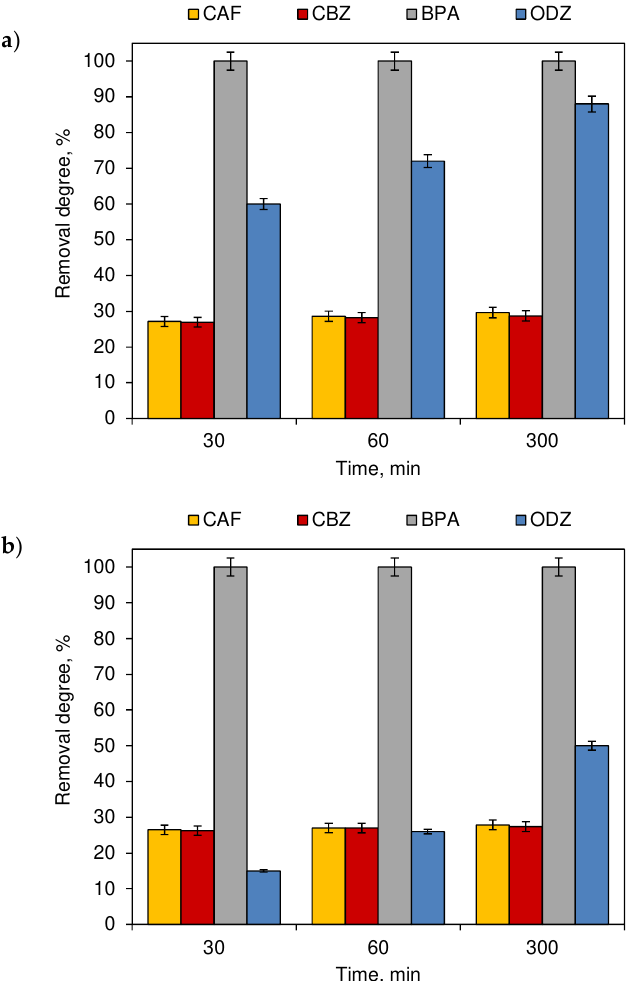
Figure 6. The removal degree of CECs chlorinated swimming pool water mixtures exposed to ( a ) sunlight (outdoor swimming pool) and ( b ) artificial lighting (indoor swimming pool) ( n = 3; where CAF—caffeine, CBZ—carbamazepine, BPA—bisphenol A, ODZ—oxadiazon).